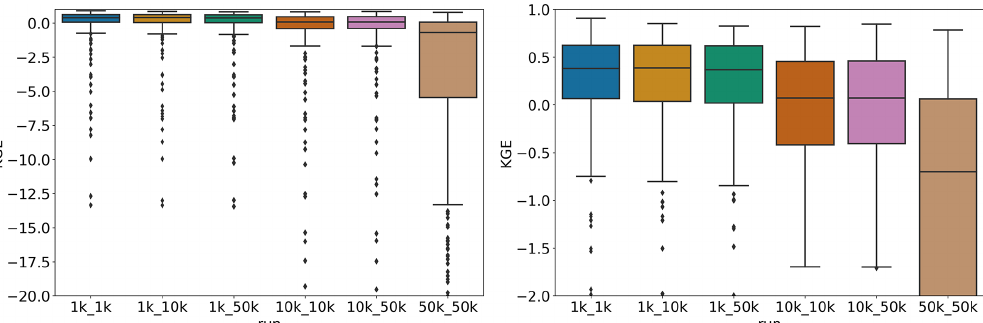
Figure 2. Box plot of KGE values obtained for all runs. The plot on the right has been magnified to show a smaller range of values.